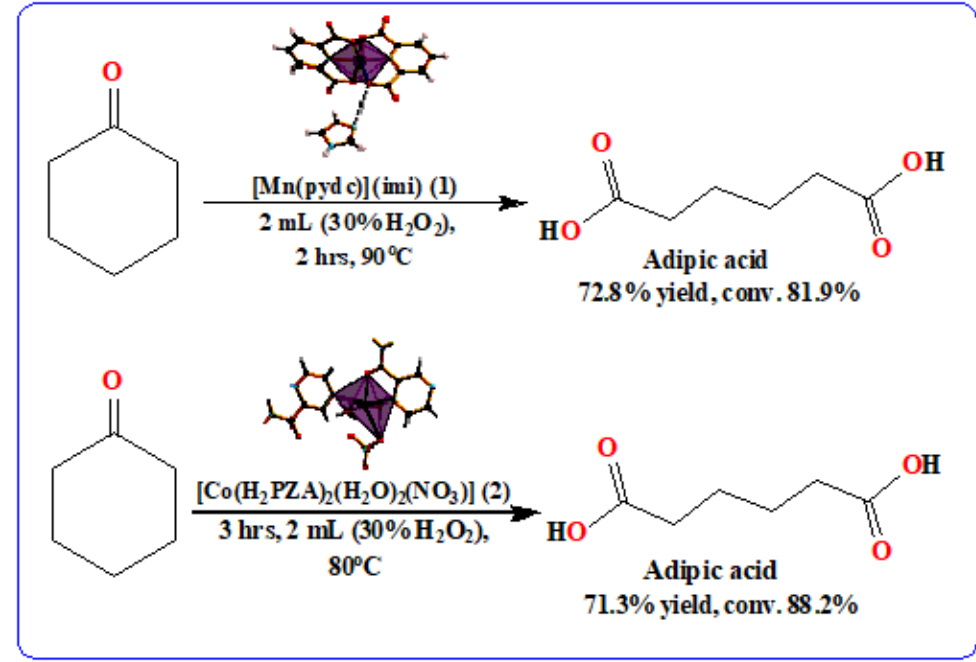
Table 2. Selected catalytic activity of compounds 1 and 2 for cyclohexanone